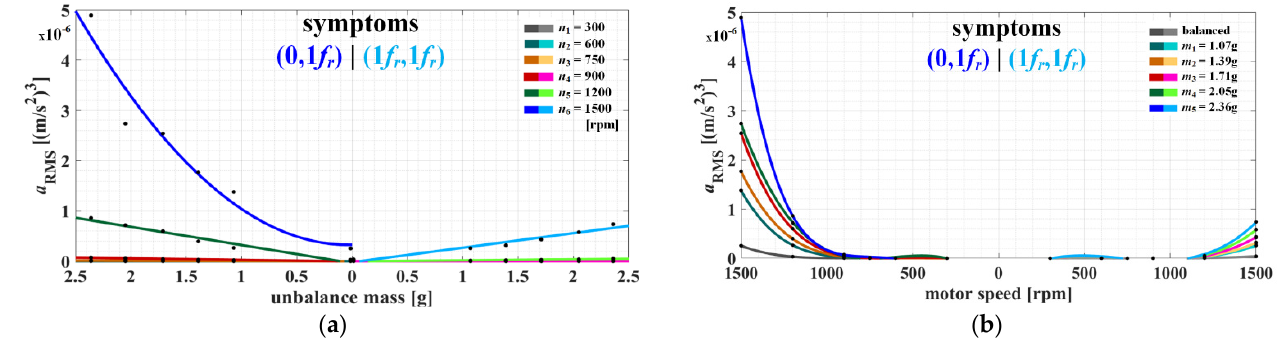
Figure 10. Symptoms (0,1 f r ) and (1 f r ,1 f r ) of mechanical vibration acceleration in bispectrum analysis as a function of unbalance mass changes, m n ( a ), and rotational speed, n ( b ).